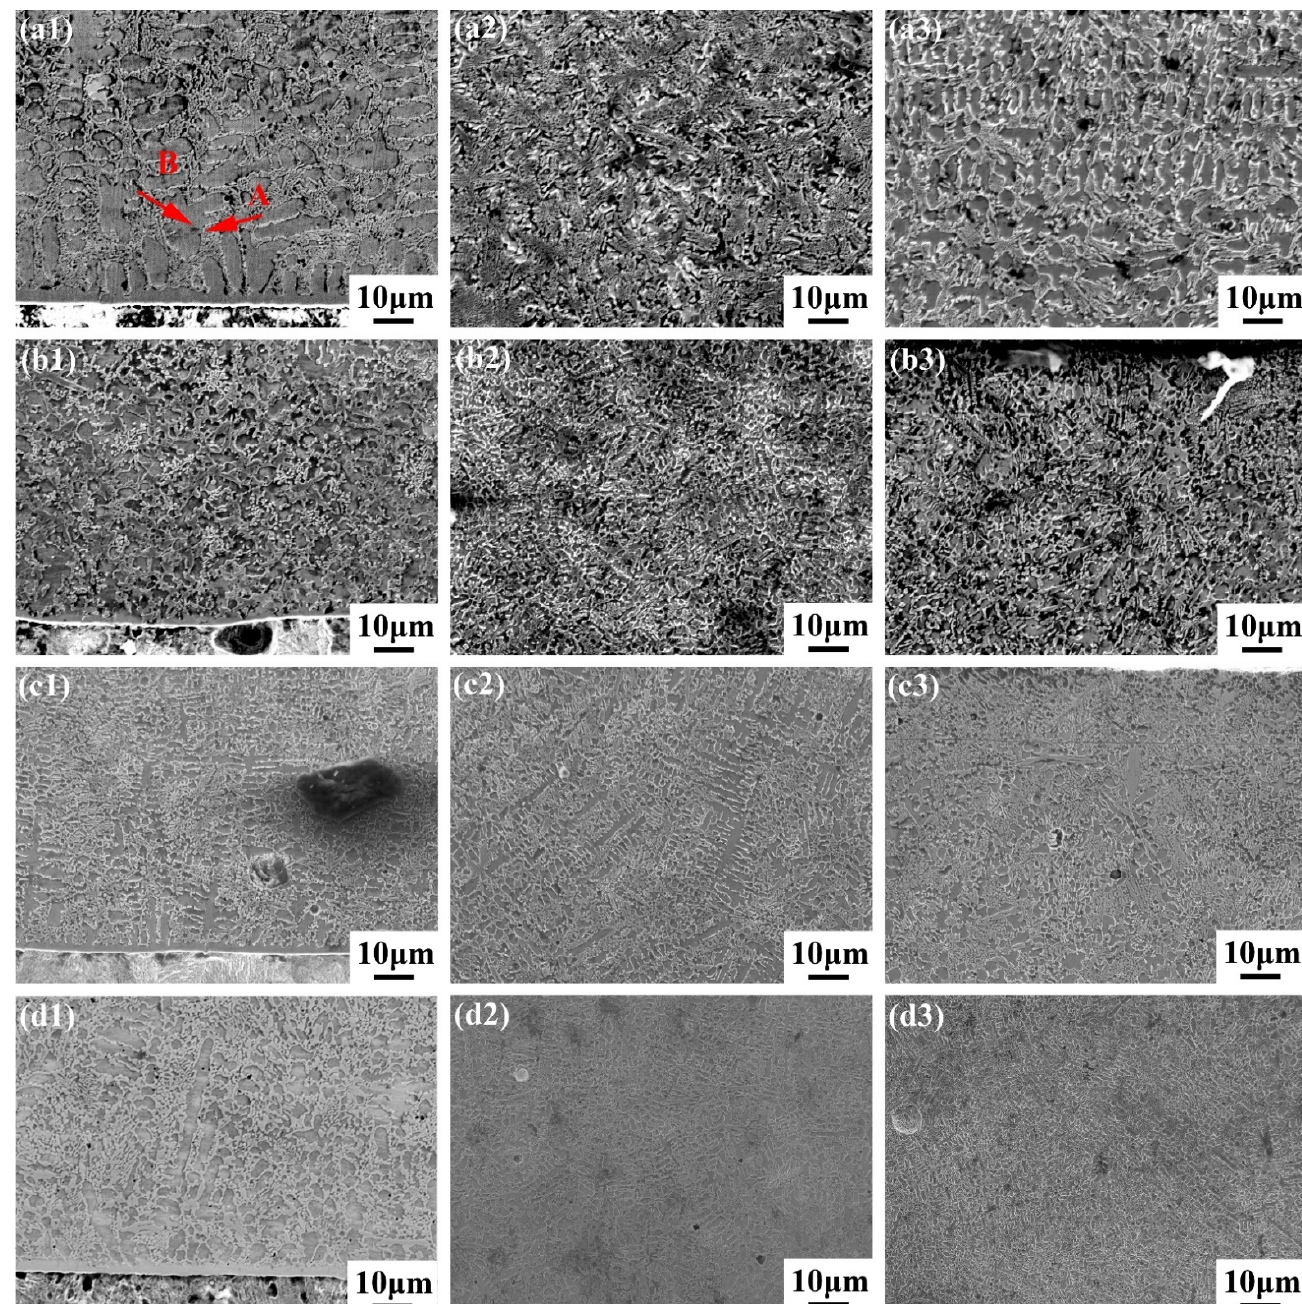
Figure 5. SEM images of cross-sectional nickel-based composite coatings with different NiGNPs content: ( a ) 0, ( b ) 10%, ( c ) 20% and ( d ) 30%. Numbers 1, 2 and 3 represent the bottom, middle and upper microstructure of the corresponding coating, respectively.